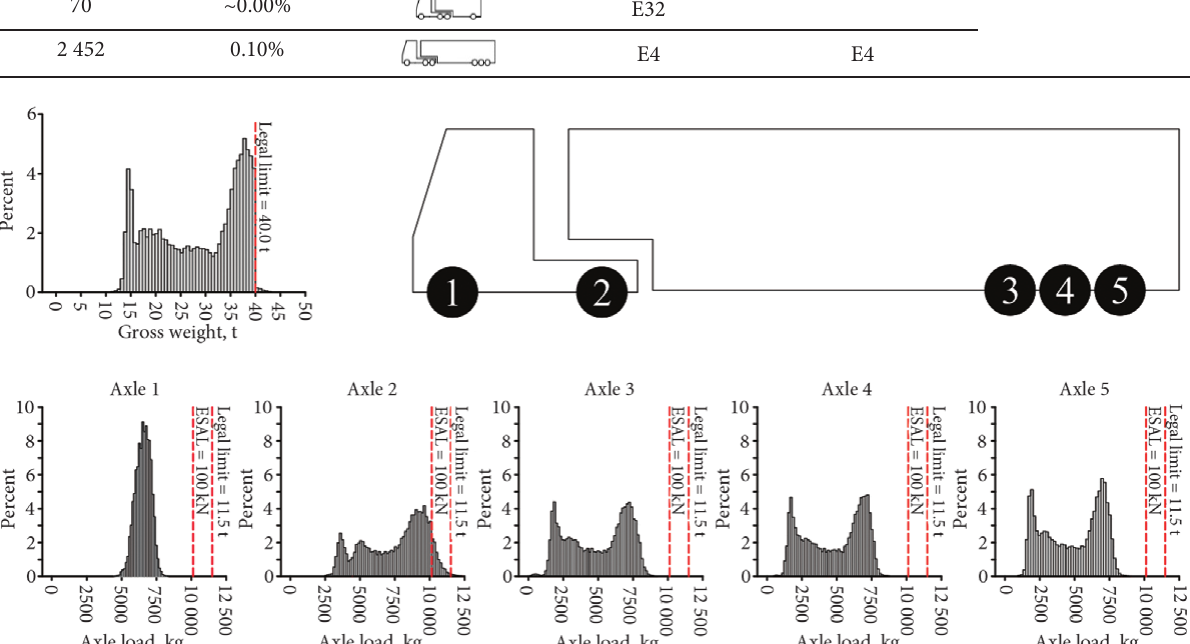
Fig. 1. Example of gross weight and axle load histograms for